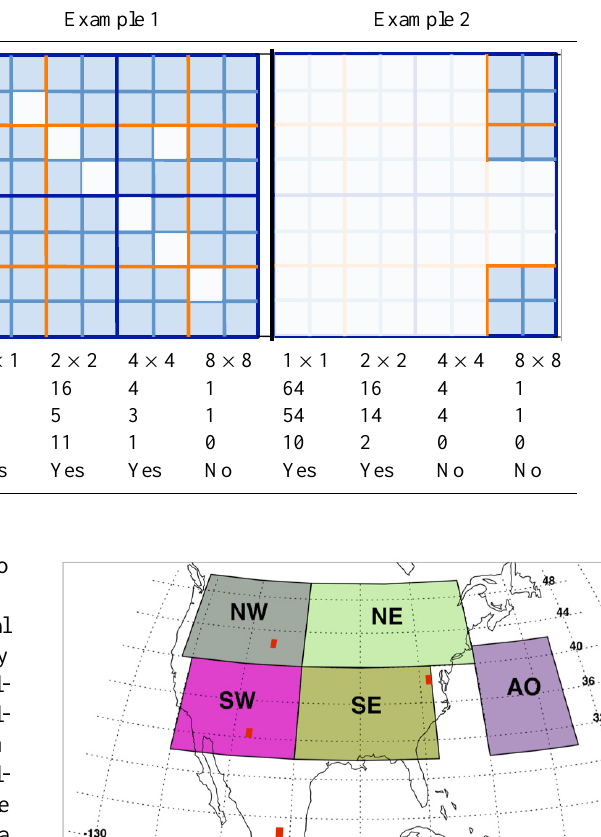
Table 2. Examples of different cloud configurations affecting retrieval opportunities in an 8x8 km product box. The last line denotes whether or not an aerosol retrieval would be made for the 8-km retrieval box, given the requirement that at least 10% of the pixels are ‘cloud-free’.